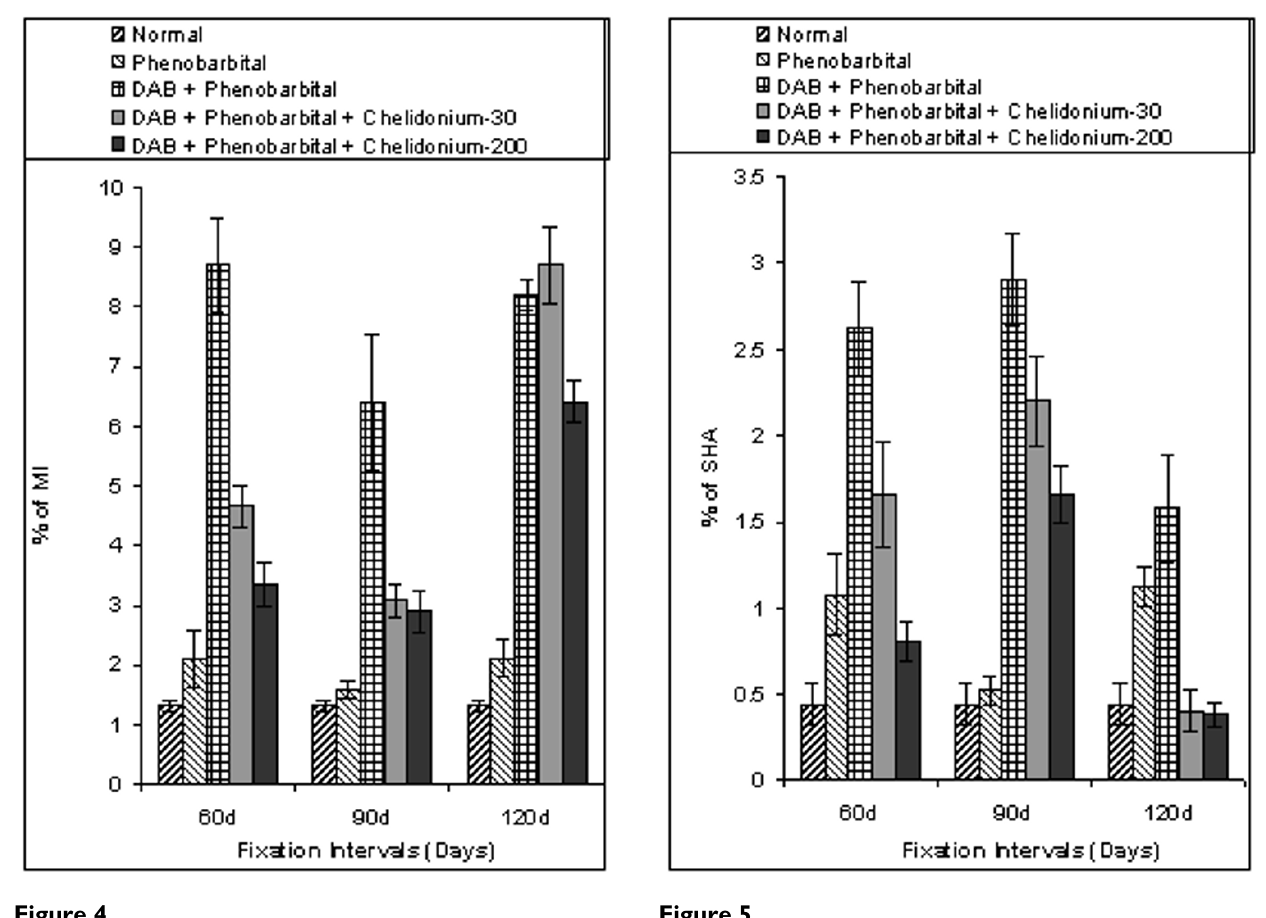
Figure 4 Showing % of MI in different series of mice at different fixa- tion intervals.